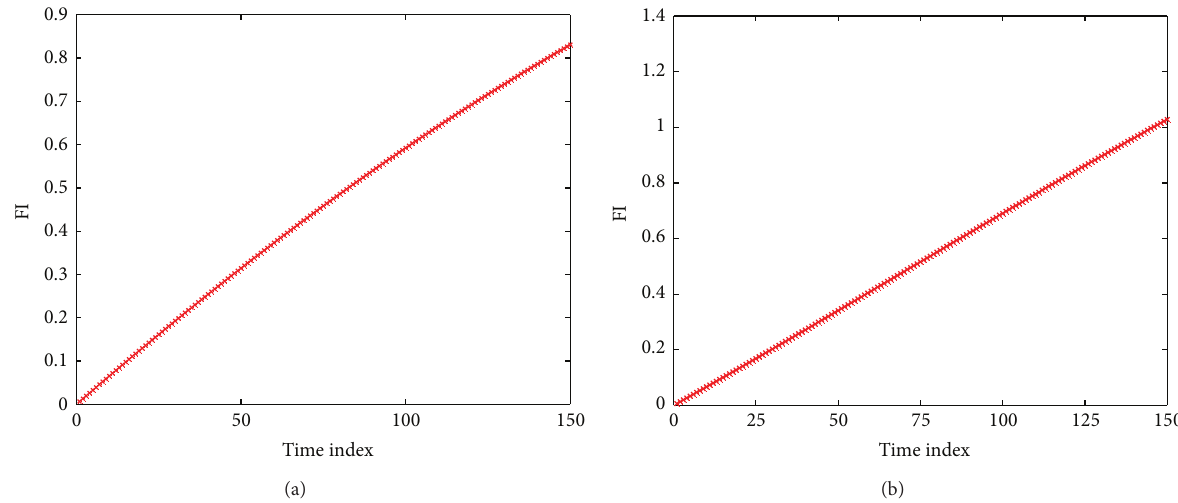
Figure 6: (a) The FI degradation model about the situation that 𝑅3 deviates from 10k Ω to 16k Ω . (b) The FI degradation model about the situation that 𝑅3 deviates from 10 k Ω to 4 k Ω .